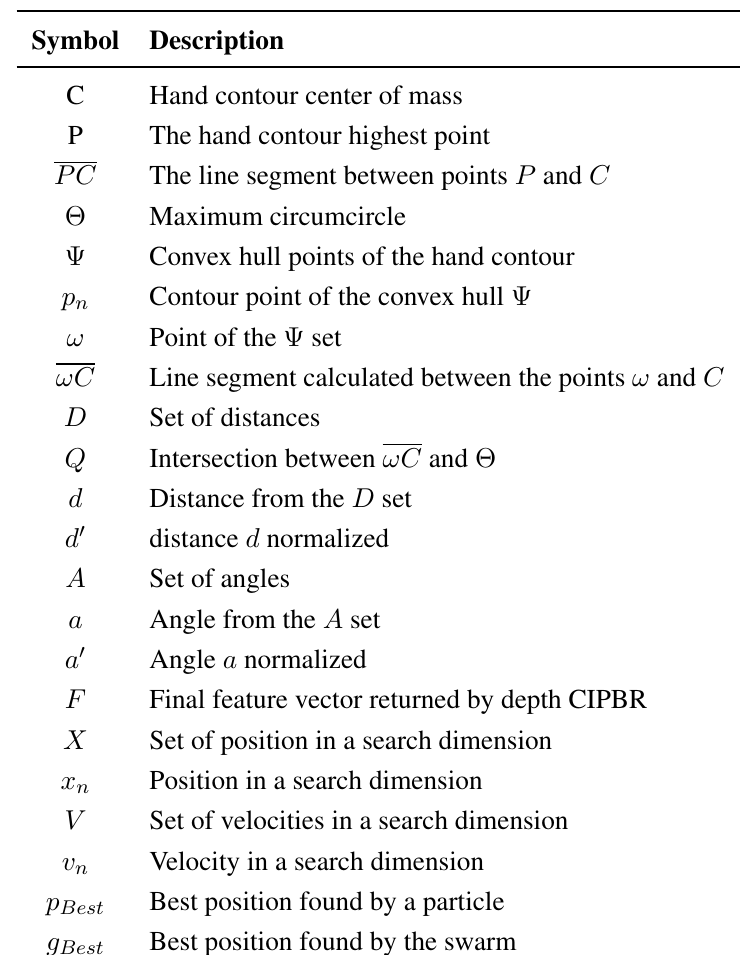
Figure 1. HAGR-D training architecture. Table 1. Notations and definitions used to describe the